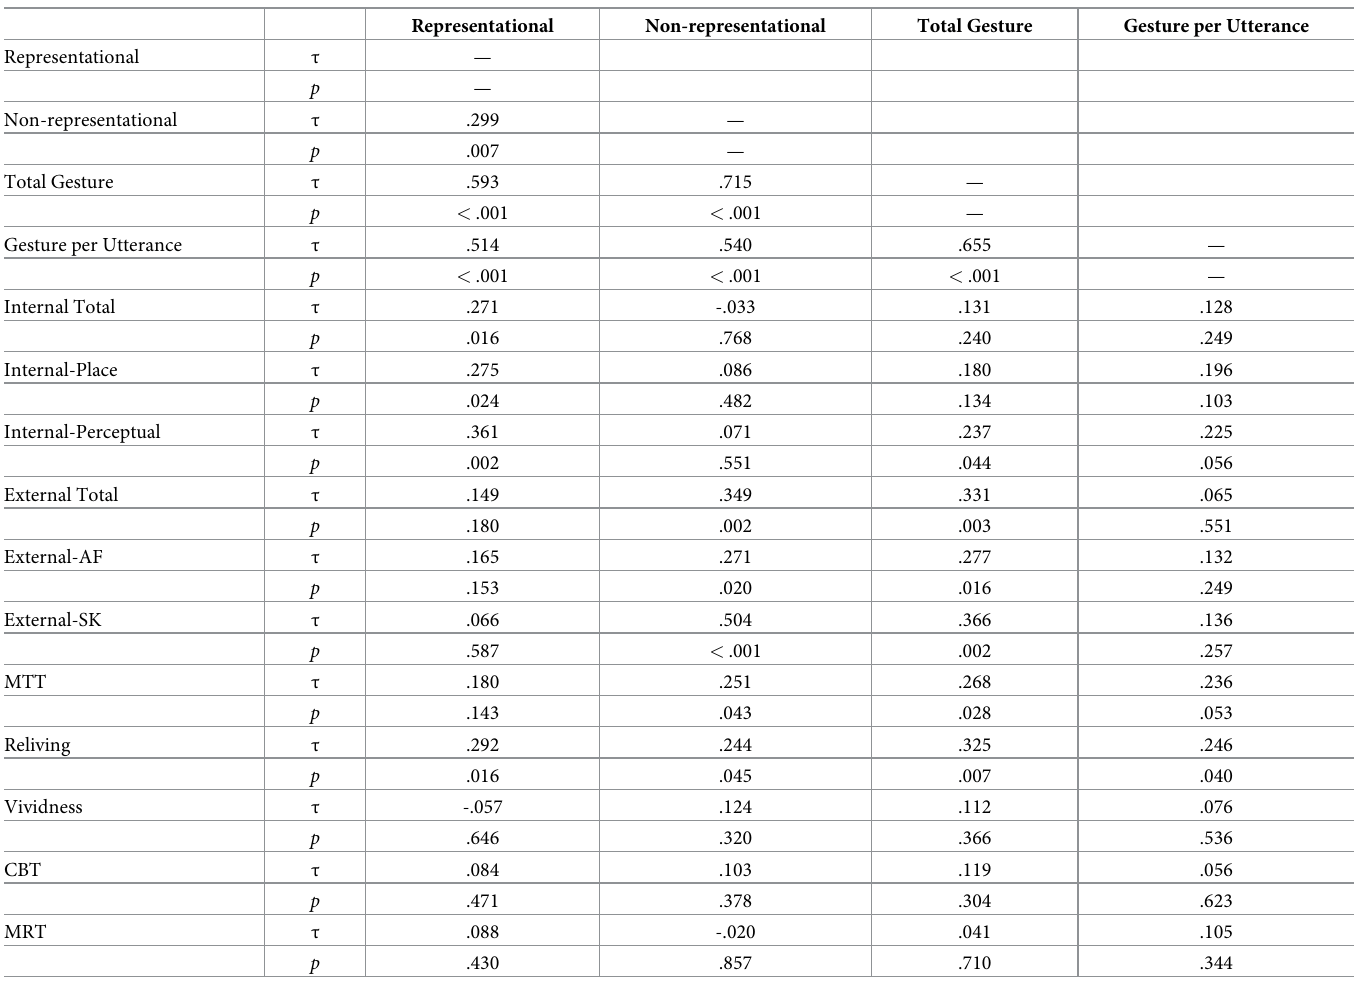
Table 2. Correlation matrix for past